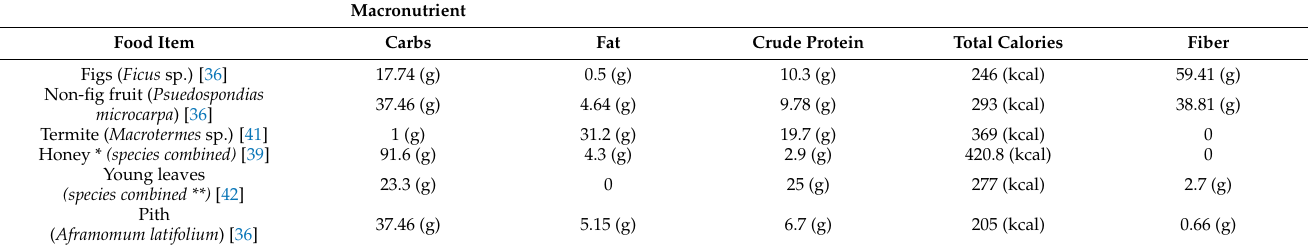
Table 1. Published macronutrient composition of representative common wild chimpanzee food items from sites in East and West Africa (Gombe and Bossou, respectively). Amounts reported are averages. Exact amounts will vary between species and location. Nutritional data was sourced from analyses conducted on chimpanzee food items in wild habitats (g/100 g). Nutritional information on honey from chimpanzee habitats is lacking, and provided data is from a study on Hadza foragers from